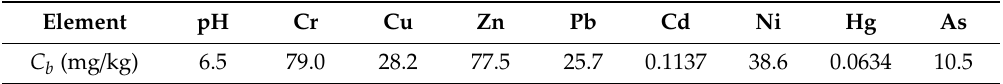
Table 1. Background soil heavy metals in the study